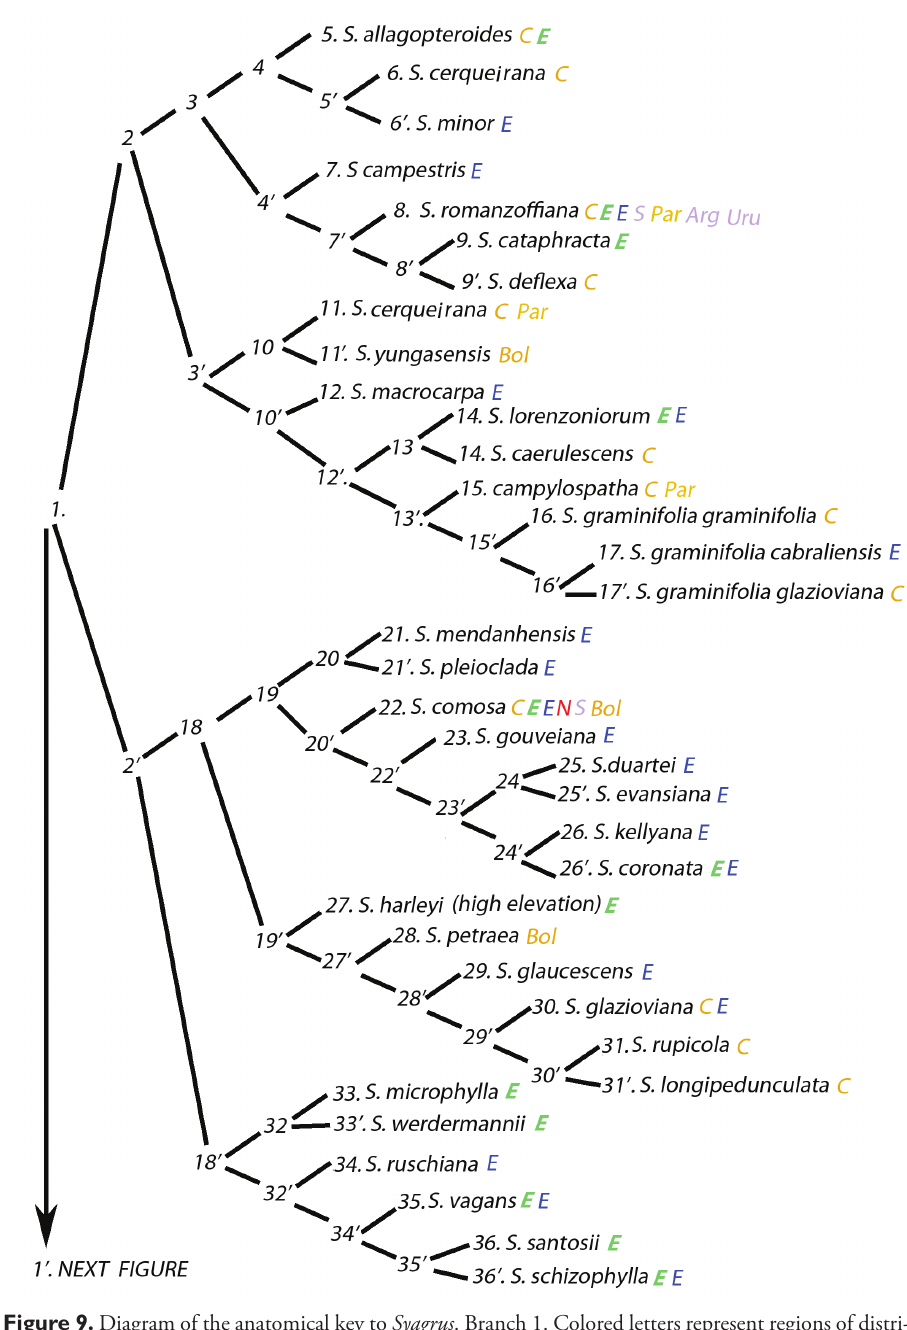
Figure 9. Diagram of the anatomical key to Syagrus . Branch 1. Colored letters represent regions of distri- bution for that species. For regions of Brazil: Orange C = Central-West Green bold italic E = Northeast Blue E = Southeast Red N = North and Violet S = South. For other countries: Arg = Argentina Bol = Bolivia Par = Paraguay and Uru =